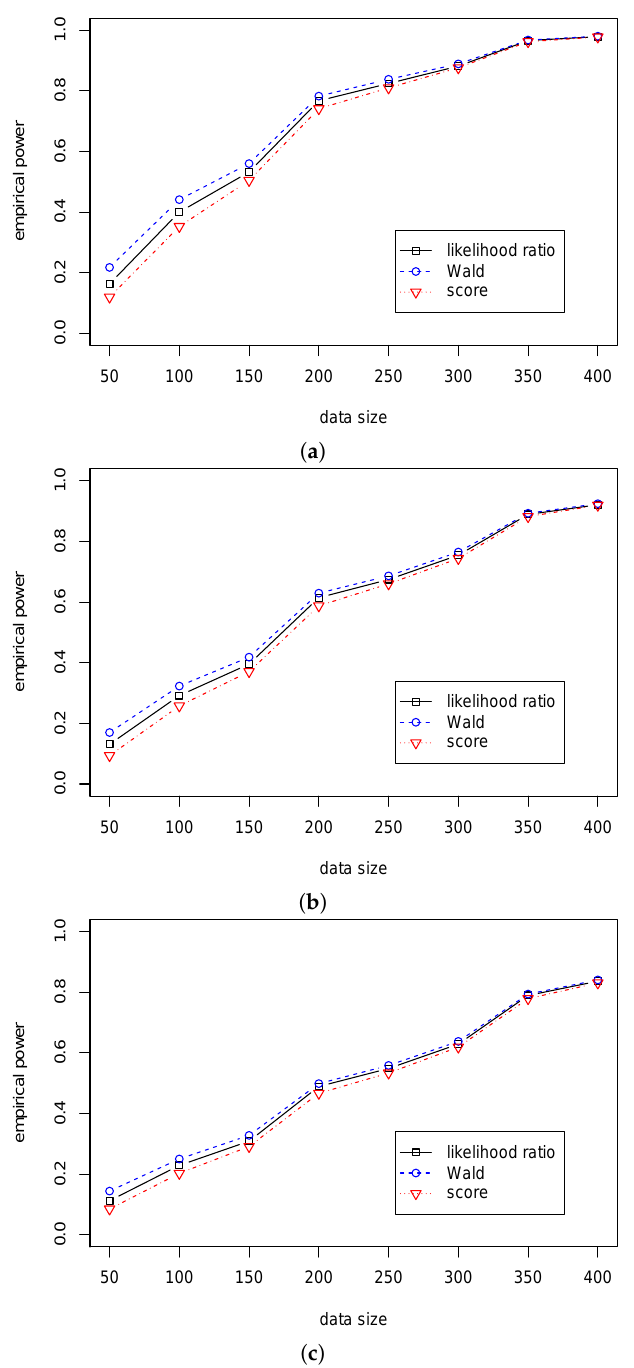
Figure 4. The empirical powers of three test statistics ( T L , T W , T S ) for testing H 0 : β 1 = β 2 = β 3 = 0 in Case (B2) for different α . ( a ) The empirical power with H 1 : β = ( 1, − 1,1, − 0.5 ) (cid:62) for α =